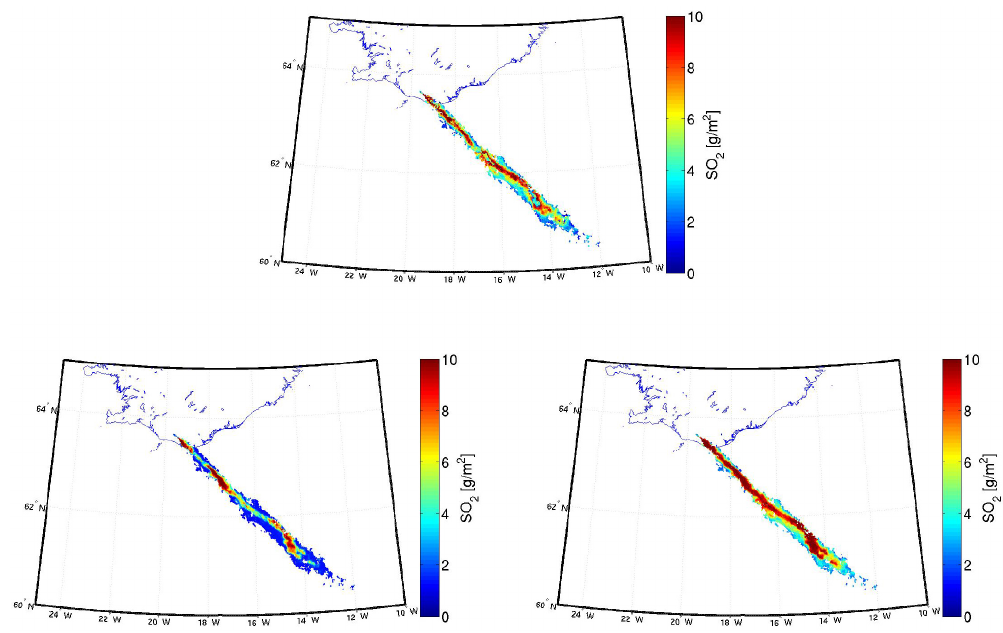
Figure 22. SO 2 columnar abundance maps for 16 May 2010: top, target retrieval; bottom left, retrieval from 3 inputs neural network; bottom right, retrieval from pruned neural